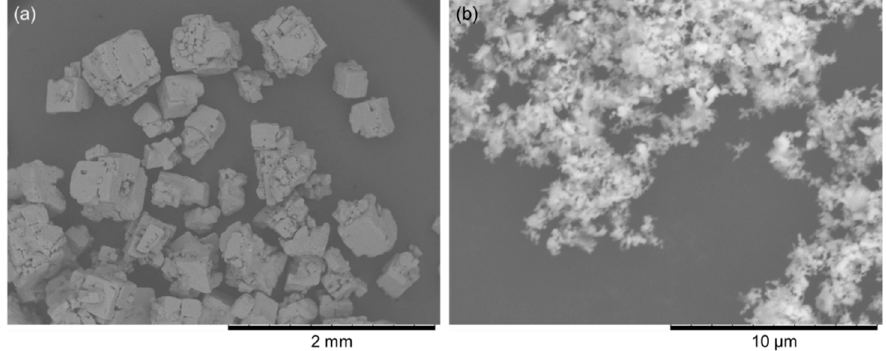
Figure 1. Photographs of the NH 4 Cl powder ( a ) and the ZnO powder ( b ).